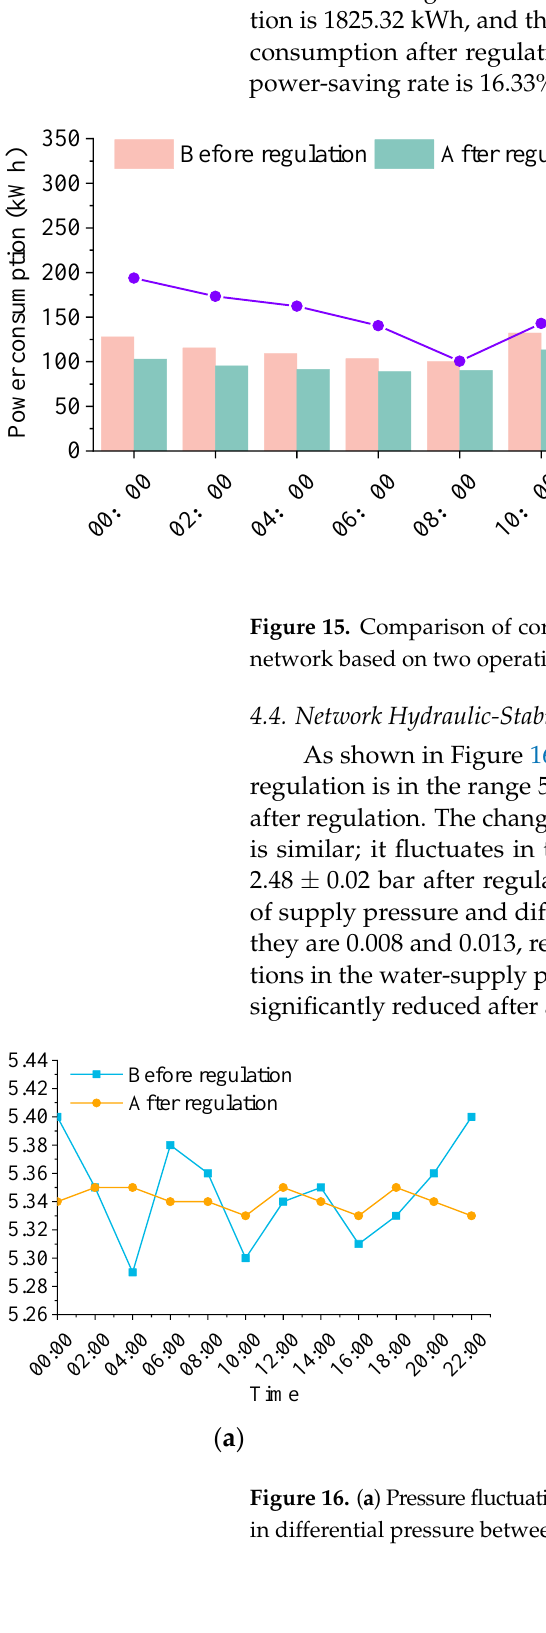
Figure 14. Comparison of modified heat load before and after adjustment.